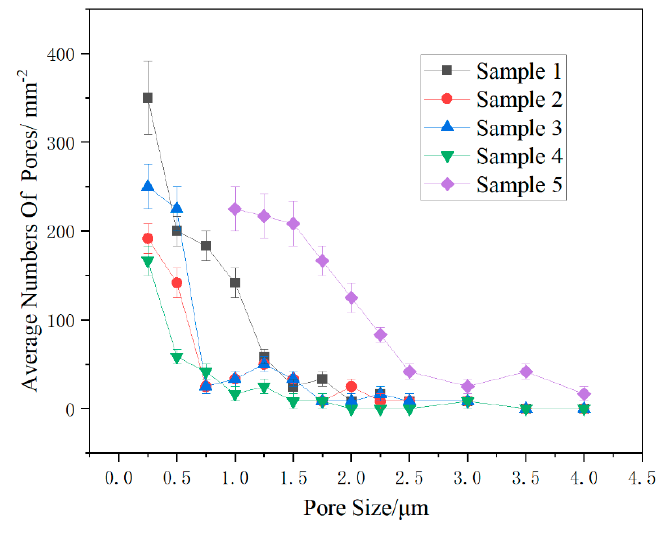
Figure 8. Pore size distributions of the coating samples after sintering.